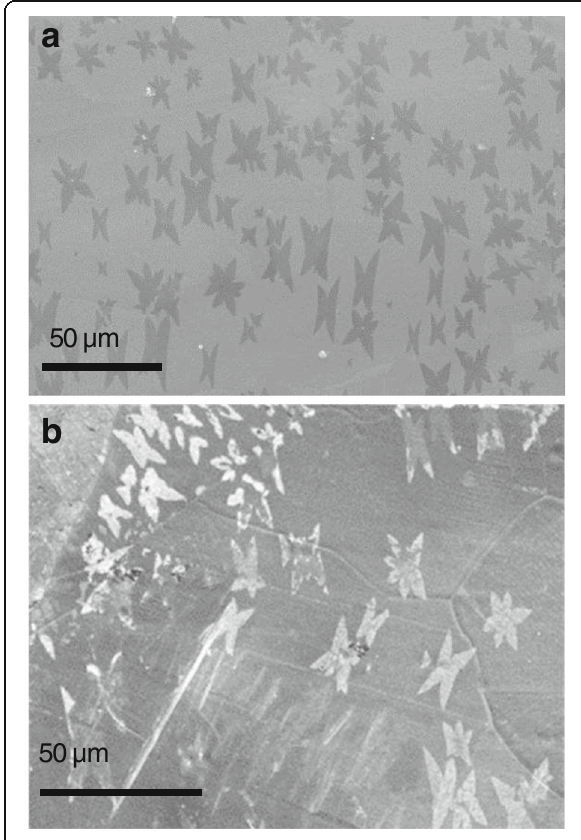
Fig. 5 SEM characterization. Detailed legend: SEM images of a of the grown graphene on top of the copper catalyst before the delamination process and b Cu2O domains reproducing graphene “ fingerprints, ” as a result of the copper oxide